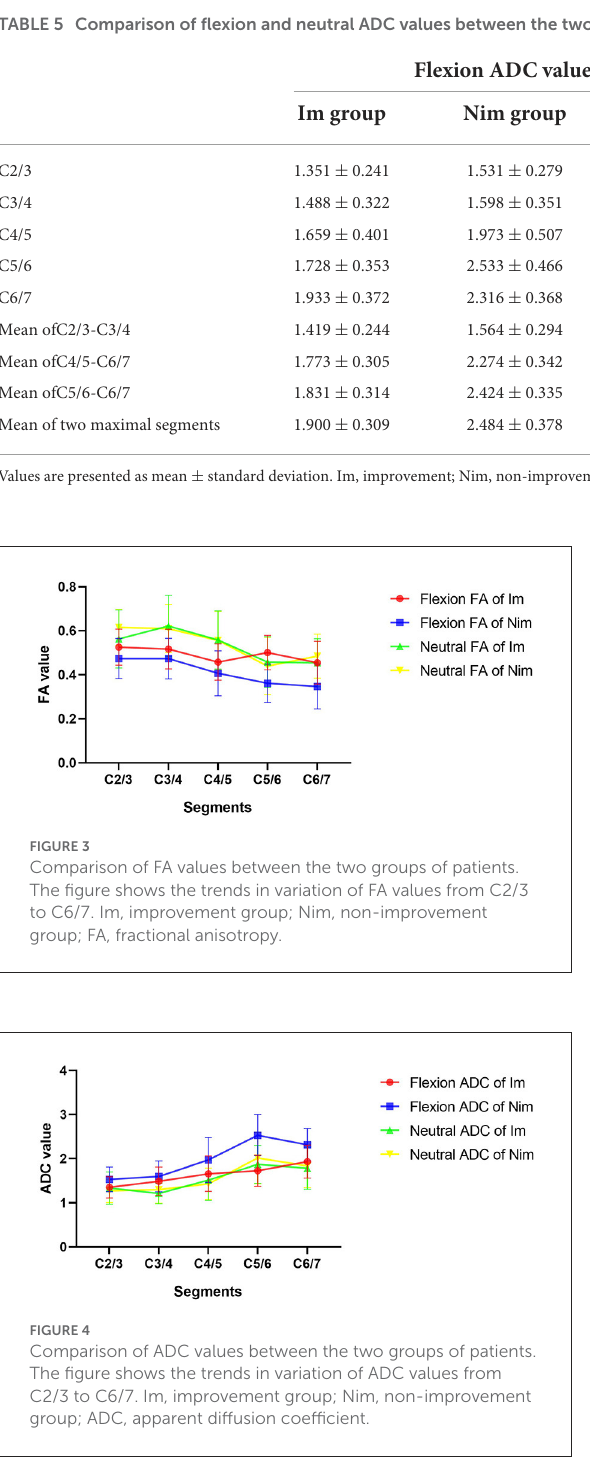
(Table 5) and there were also significant differences in flexion